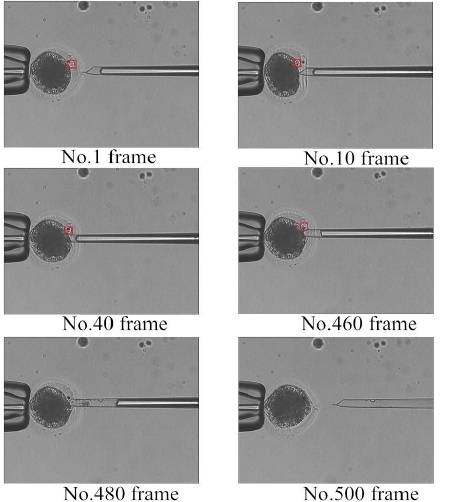
Figure 11. Detection results of the enucleation